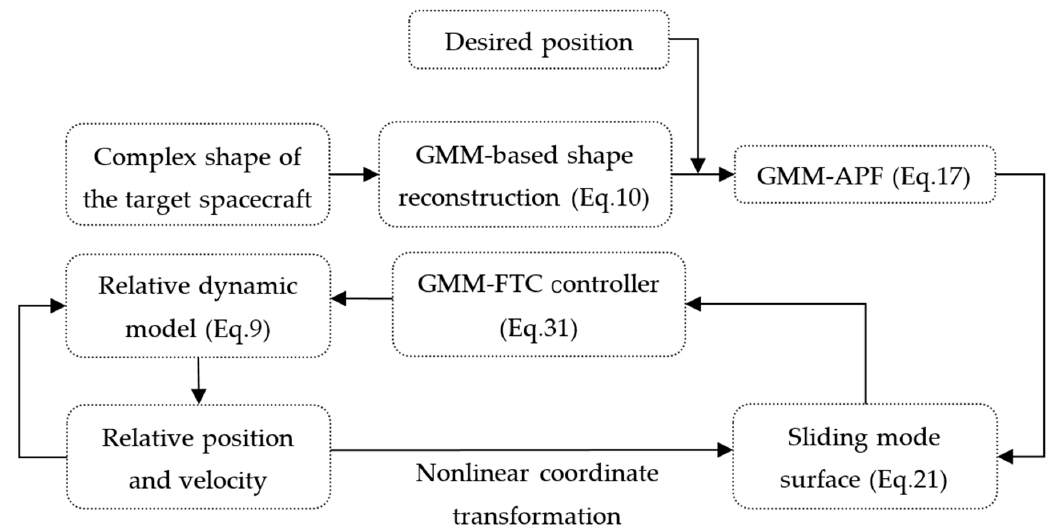
Figure 2. Flowchart of the two-spacecraft proximity operation process.